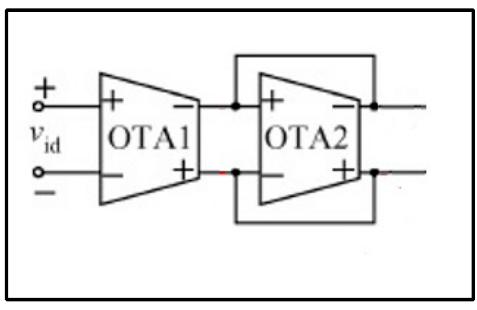
Figure 15. Setup for the fully differential to unity gain conversion.